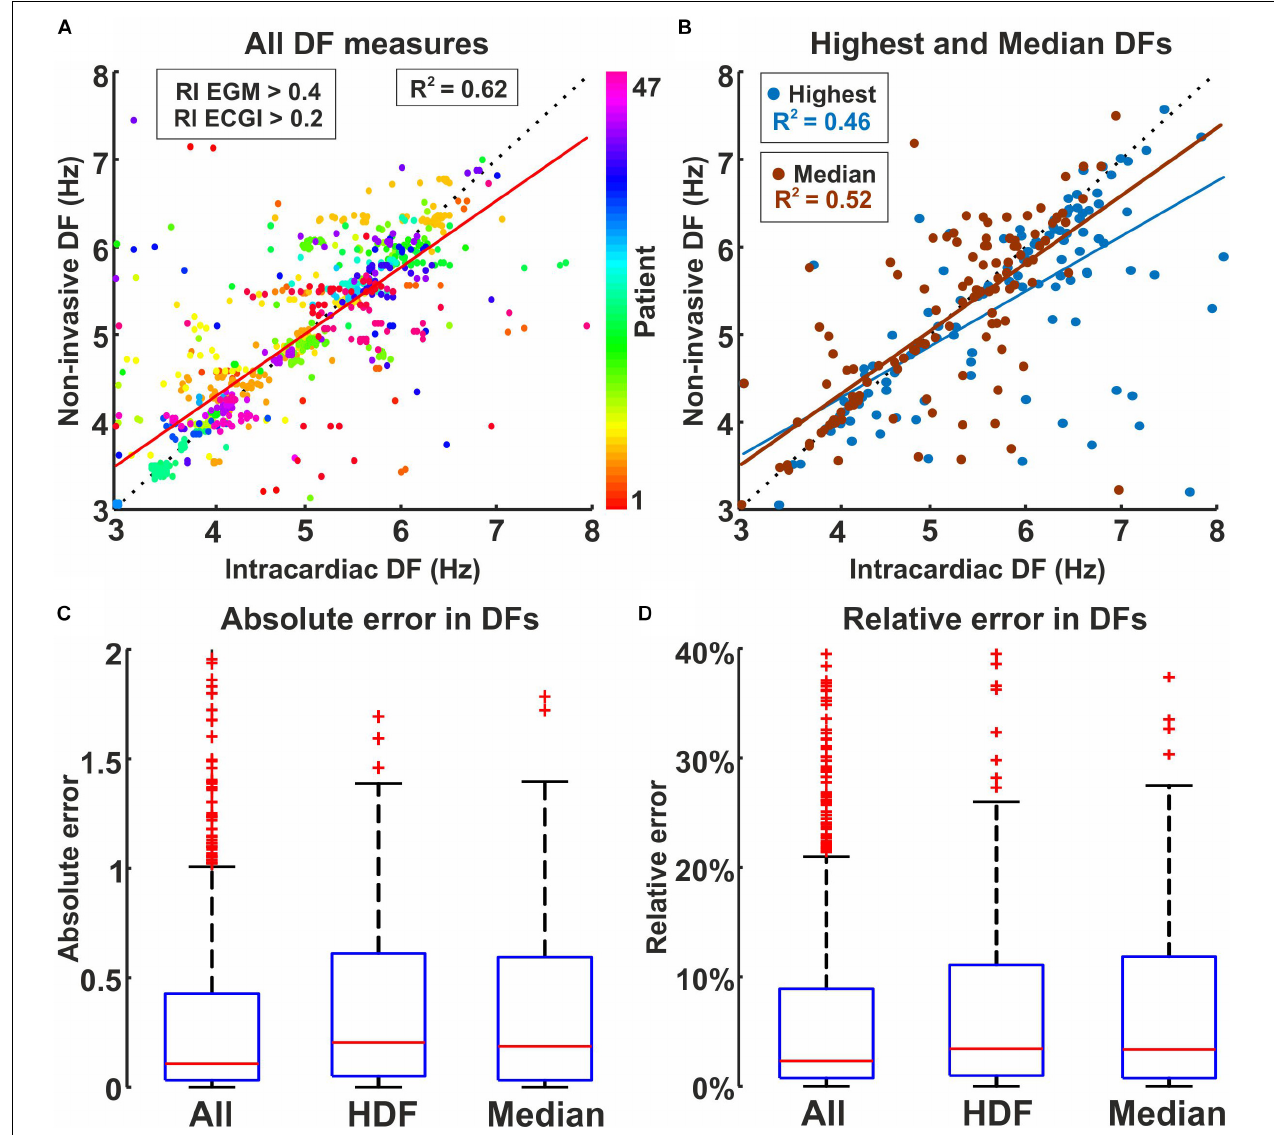
FIGURE 3 | Intracardiac and non-invasive DF measures filtered by spectral organization (RI). (A) Dispersion plot by patient, using RI (intracardiac) > 0.4 and RI (non-invasive) > 0.2. (B) Dispersion plot coded by highest DF (blue) and Median DF (red). (C) Absolute and (D) relative (% of intracardiac measure) difference for all electrodes, Highest DF and Median